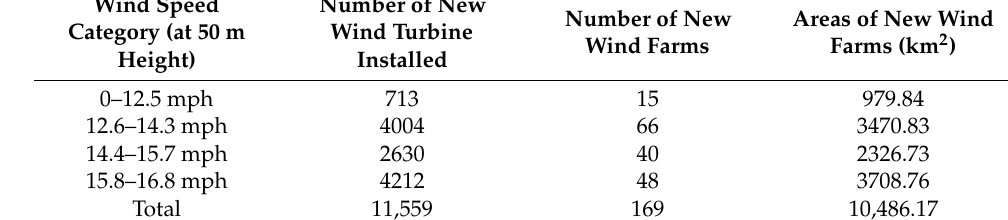
Table 2. Wind turbines and wind farms installed in Texas (2010 to 2019).